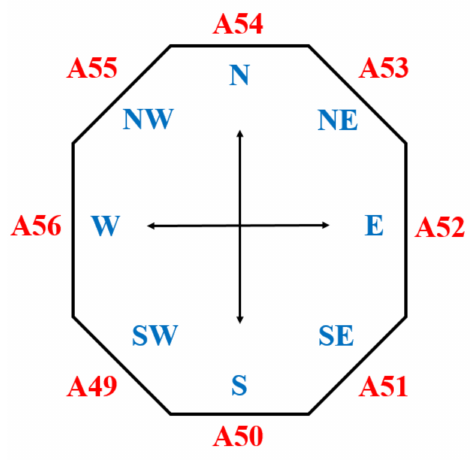
Figure 9. Partition